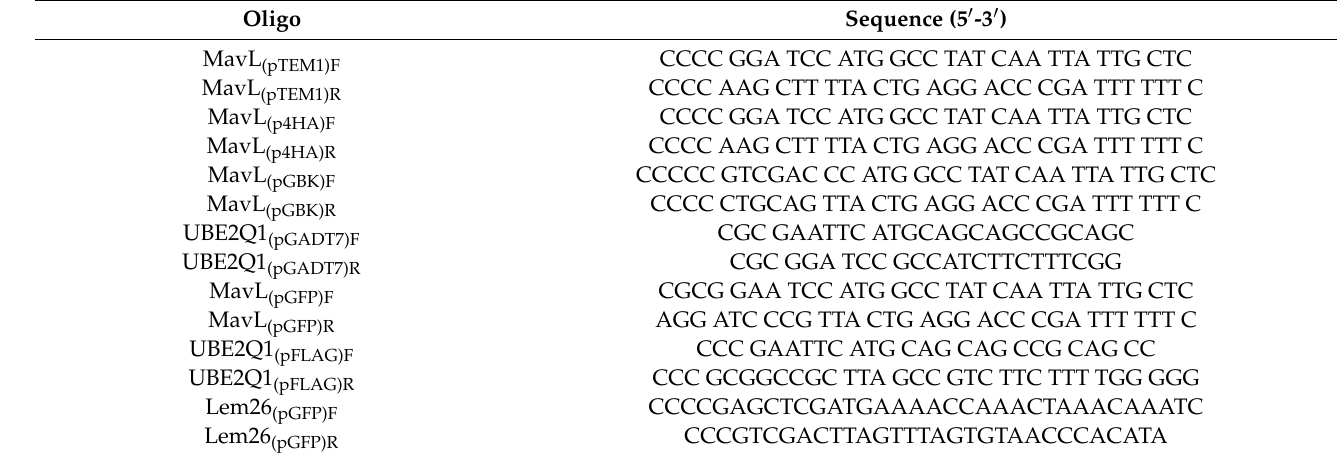
Table 2. List of primers used in this